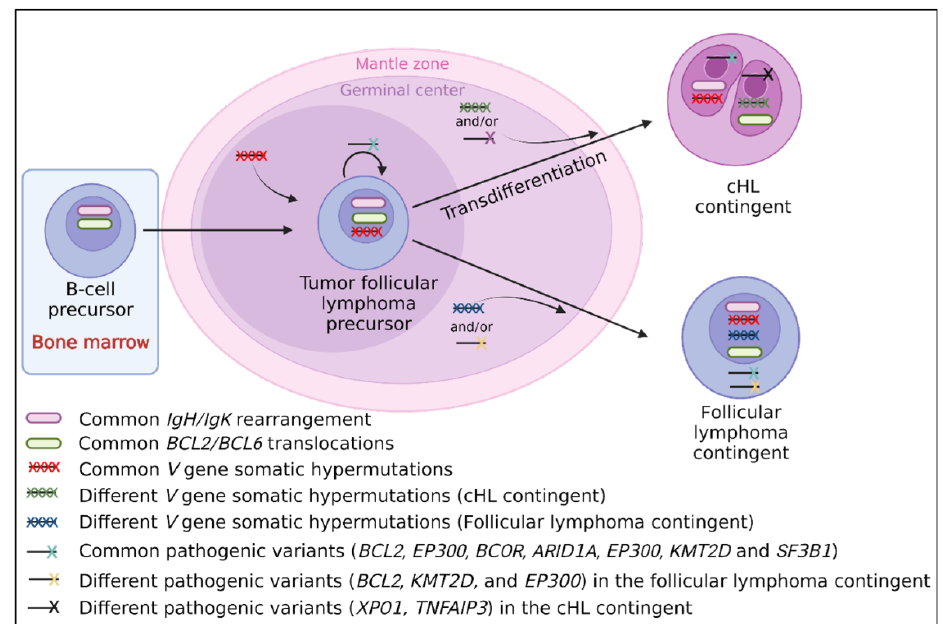
Figure 3. Suggested transdifferentiation model of a follicular lymphoma precursor into classical Hodgkin lymphoma (cHL) contingent in cHL/follicular composite lymphomas. The transdifferentiation model in this type of composite lymphoma is based on the presence of (i) BCL2/BCL6 translocations in both contingents and similar IgH/IgK rearrangements which take place in early B-cells in the bone marrow [10,123]; (ii) identical V gene somatic hypermutations [6,11,12], indicating that the tumoral precursor matures through the germinal center; (iii) identical driver pathogenic follicular lymphoma-like variants ( KMT2D, BCL2, EP300 , and ARID1A ) [10], indicating that the common tumoral precursor is probably a tumor follicular cell; (iv) different V gene somatic hypermutations between both contingents [6,11,12], indicating that the separation of both contingents takes place during the germinal center step; and (v) different passenger variants, specific to each contingent ( XPO1, TNFAIP3 found in the cHL contingent only, and BCL2, KMT2D, and EP300 found in the follicular lymphoma contingent only) [10], indicating that each contingent evolves independently after the transdifferentiation step.